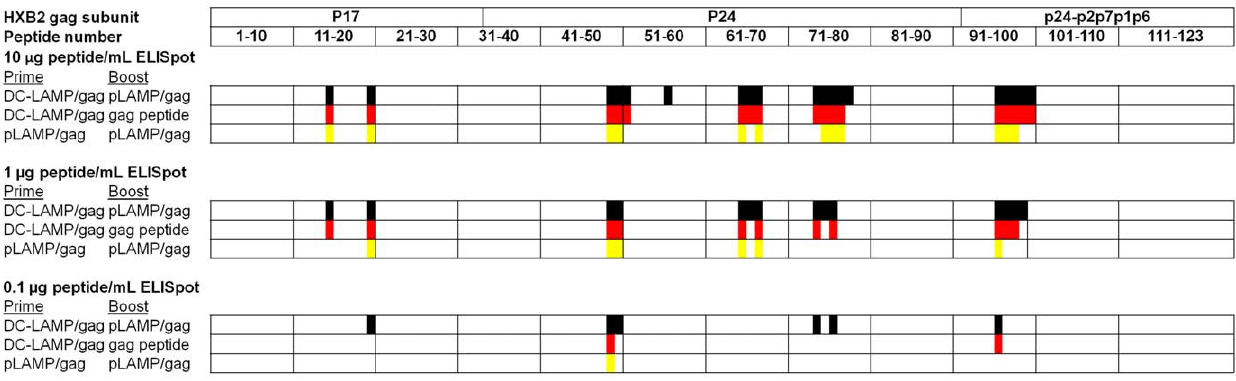
Figure 1. Peptide specificity and relative avidity of IFN- c -secreting HIV-1 Gag-specific T-cell responses in BALB/c mice immunized with pLAMP/gag-based prime and boost formulations. Mice were immunized subcutaneously with naked pLAMP/gag plasmid 50 m g DNA or with 1 6 10 5 pLAMP/gag-transfected immature DCs (DC-LAMP/gag), and boosted with naked pLAMP/gag plasmid (lower and upper lines) or Gag peptides (middle line). Gag peptide-specific T cell responses were measured by ex vivo IFN- c ELISpot assay at peptide concentration of 10 m g/ml (top), 1 m g/ml (middle), and 0.1 m g/ml (bottom), as described in Materials and Methods. The domain structure of the unprocessed HIV-1 Gag protein, and the numbering of the corresponding peptides are indicated on the top. Colored boxes indicate peptides eliciting positive IFN- c ELISpot responses in mice immunized with pLAMP/gag plasmid DNA prime/boost (yellow), DC-LAMP/gag prime and Gag peptide boost (red), and DC-LAMP/ gag prime and pLAMP/gag plasmid DNA boost (black).